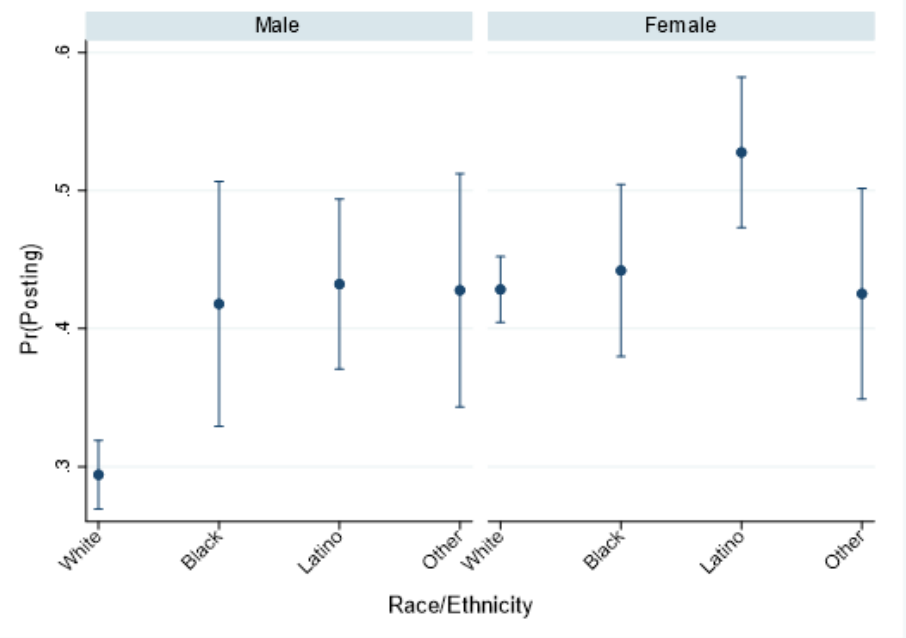
Figure 1. Predicted probabilities of posting (95% CI) for each gender by race and ethnicity. Pr(Posting): probability of